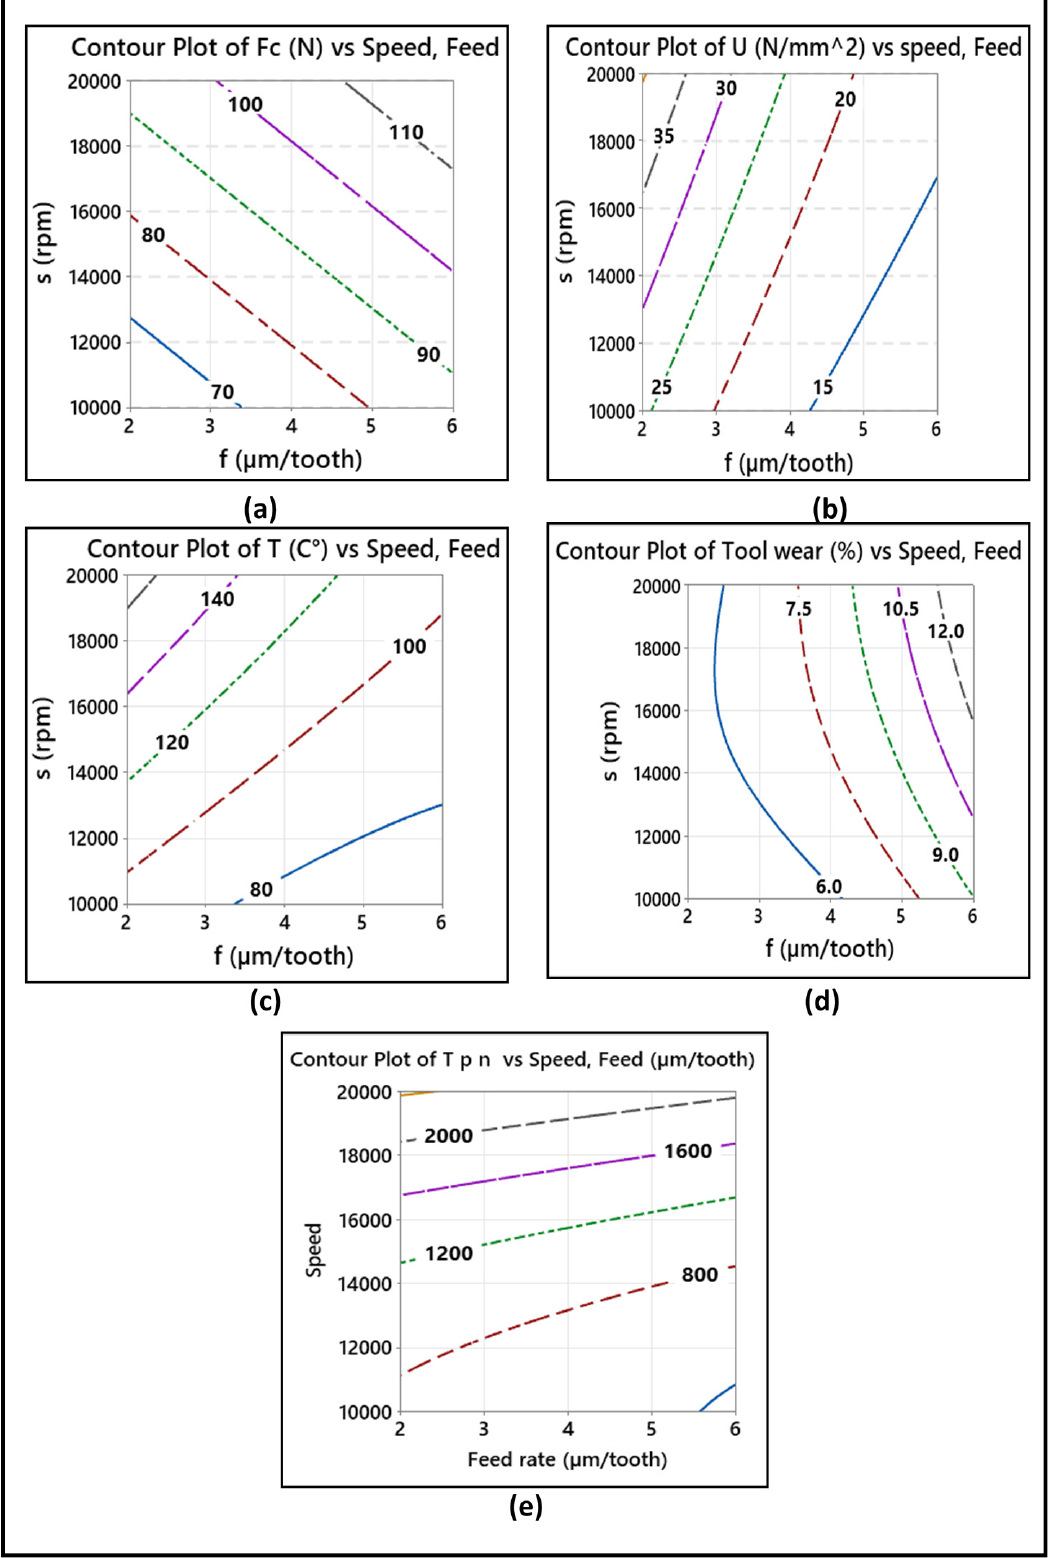
Figure 13. Corresponding contour plots showing effect of cutting parameters on ( a ) cutting force, ( b ) specific cutting energy, ( c ) temperature, ( d ) tool wear, ( d ) total particles number Tpn ( ≠ /cm 3 ).